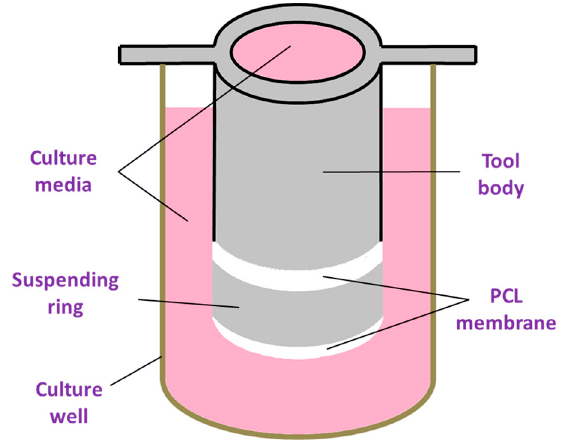
Figure 1. Schematic of the 3D-printed cell culture tool.